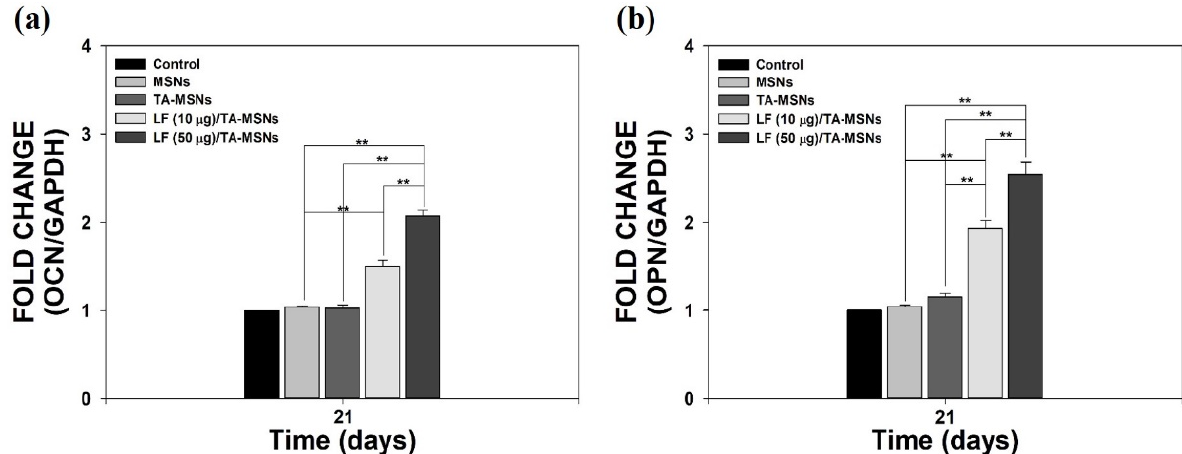
Figure 6. The mRNA levels of ( a ) OCN and ( b ) OPN in ADSCs cultured with bare MSNs, TA-MSNs, LF (10 μ g)/TA-MSNs, or LF (50 μ g)/TA-MSNs after 7 and 21 days of incubation ( n = 4 per group). ** p < 0.01.